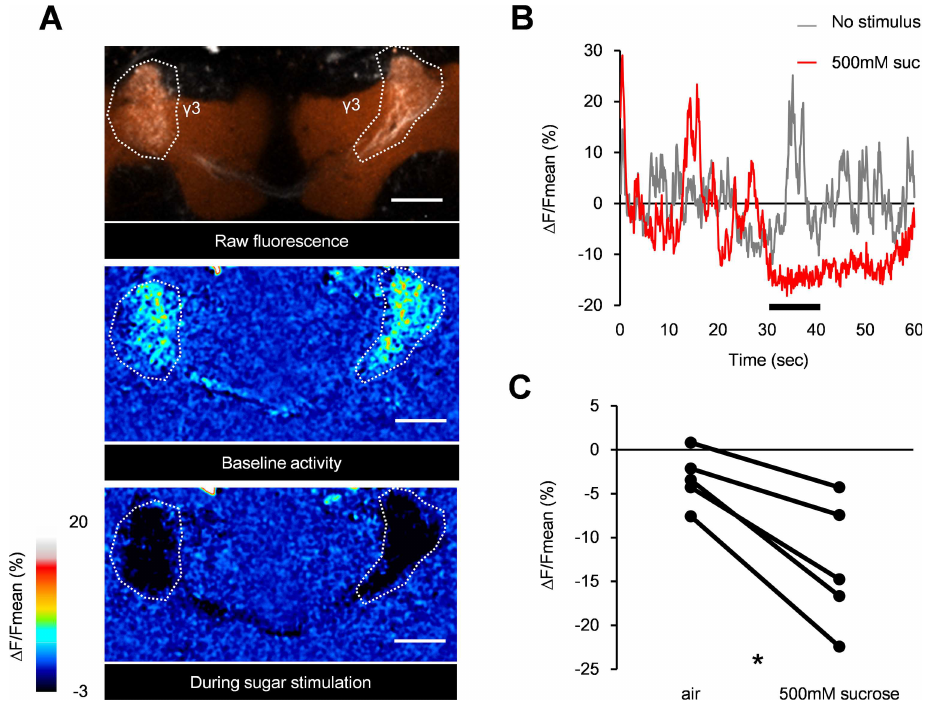
Fig 3. Sugar reward suppresses the baseline activity of PAM- γ 3. (A) Representative raw fluorescence in the PAM- γ 3neuronsof the MB441B-GAL4 / UAS-GCaMP5 fly with the mushroombodies labelledwith dsRed (orange).Two-photon images for one second before (baseline)and duringthe first second of sucrose stimulation(duringsugar) are averagedand presented in a pseudocolor code. Regionof interest is definedby terminals of PAM- γ 3in the medial lobes (outlined).Scale bar, 20 μ m. (B) Time course of baselineactivity (gray) and sugar response(red). Black bar: stimulus application.(C) Average calcium responses of PAM- γ 3 neurons. Sucrose ingestionsignificantly reducesthe activity level of PAM- γ 3 (Wilcoxonmatched-pairs signed rank test, n = 5). * p < 0.05.